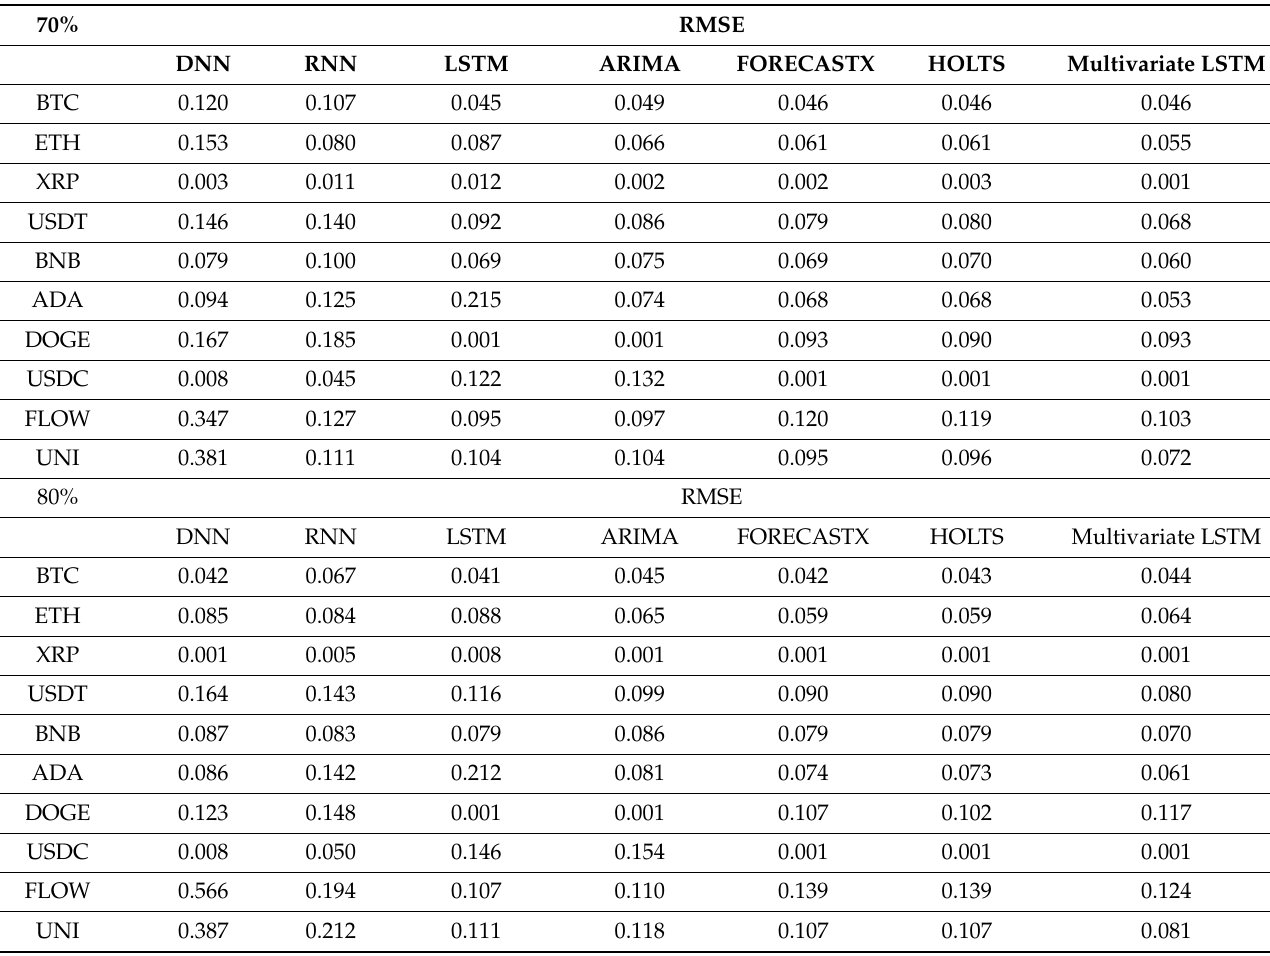
Table 2. Measuring predictions using